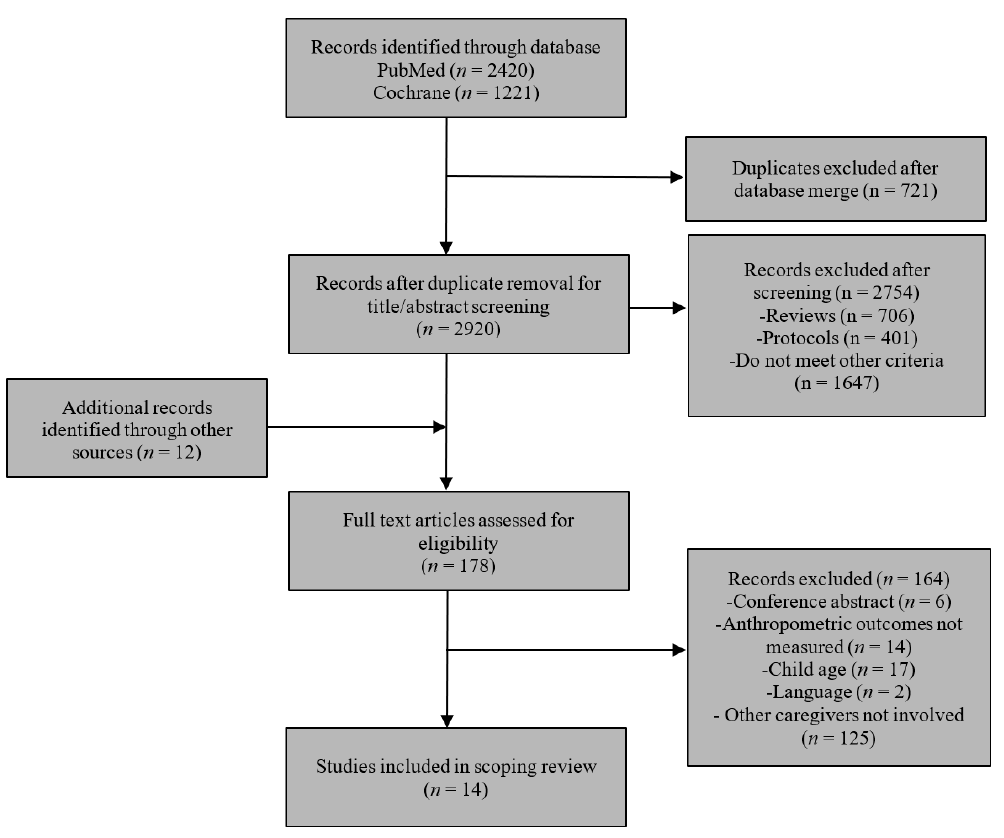
Figure 1. Screening process.